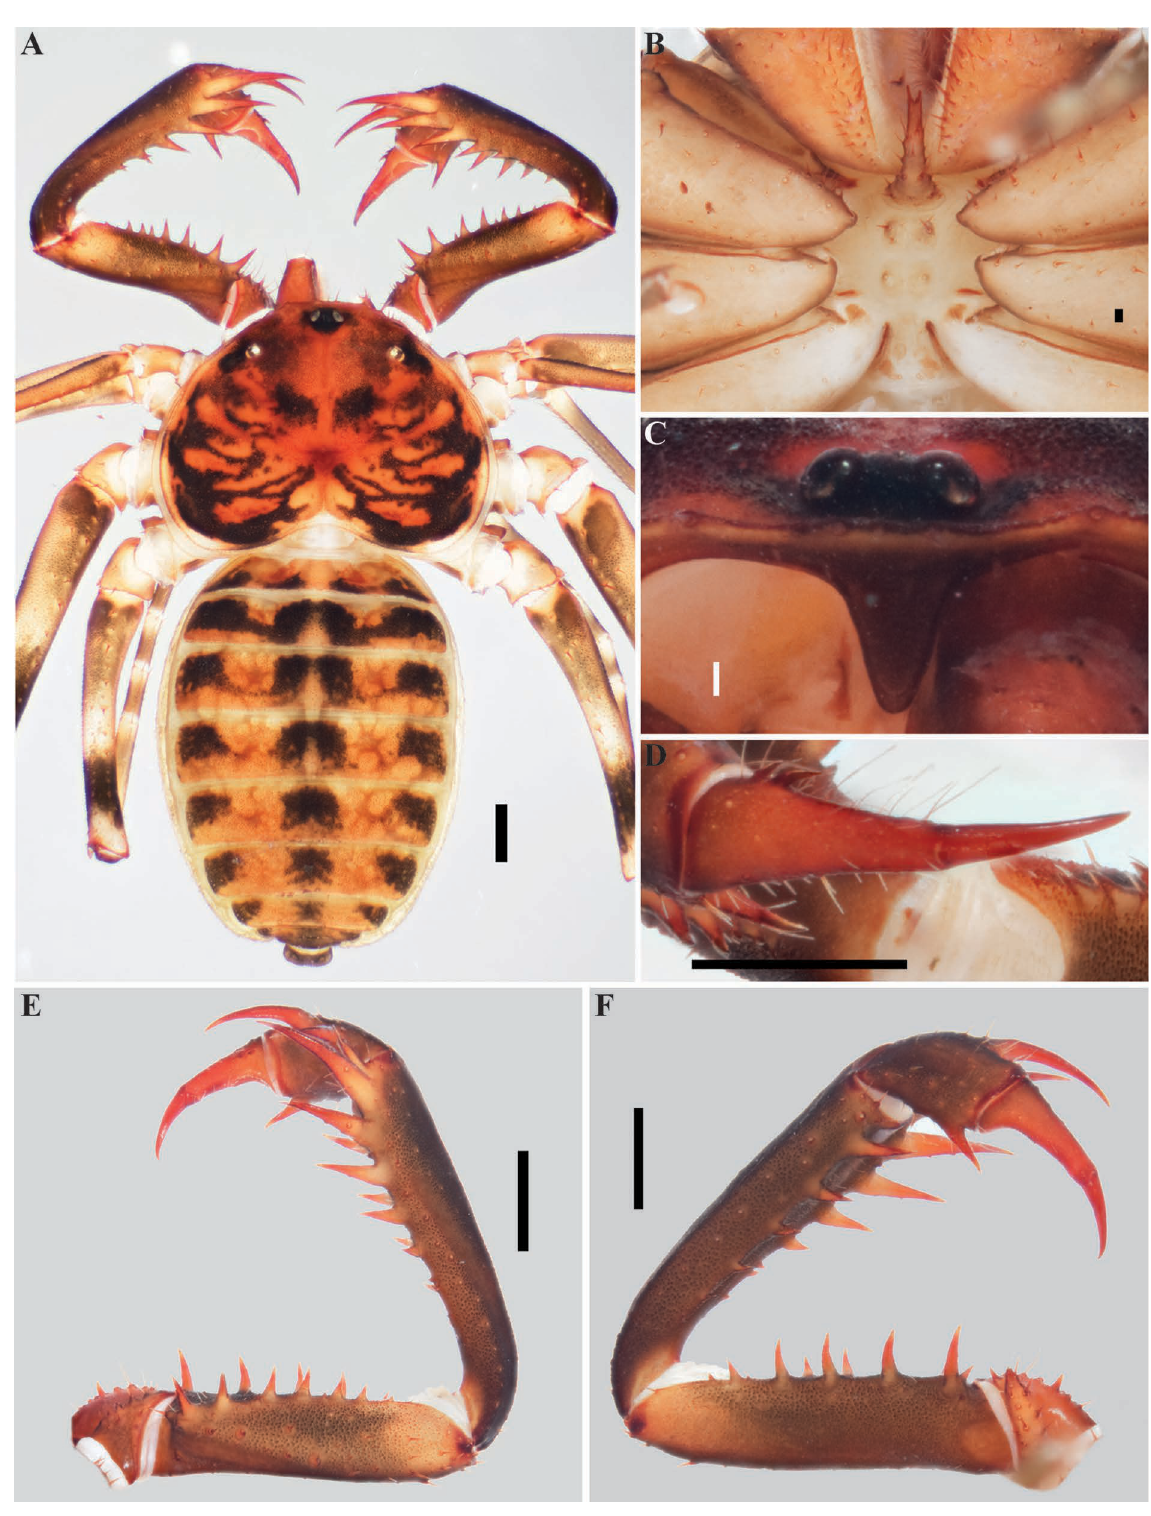
Fig. 29. Charinus gertschi Goodnight & Goodnight, 1946 (AMCC [LP 10076]), general morphology, ♂. A . Habitus, dorsal view. B . Sternum, ventral view. C . Frontal process. D . Pedipalp tarsus, frontal view. E . Pedipalp, dorsal view. F . Pedipalp, ventral view. Scale bars: A, D–F = 1 mm; B–C =